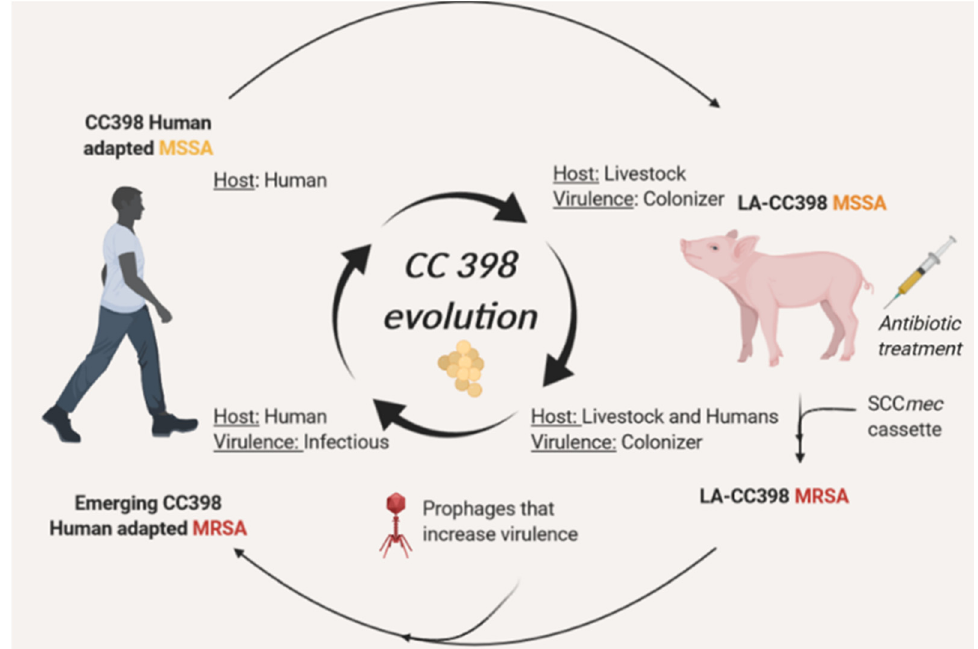
Figure 1. Emergence of CC398 human-adapted MRSA clade. CC398 human-adapted clade is the name of the presumed methicillin-susceptible ancestor clade. Evolution of tropism through cattle and integration of prophages/SCCmec element led to the emergence of the new methicillin-resistant human adapted clade.